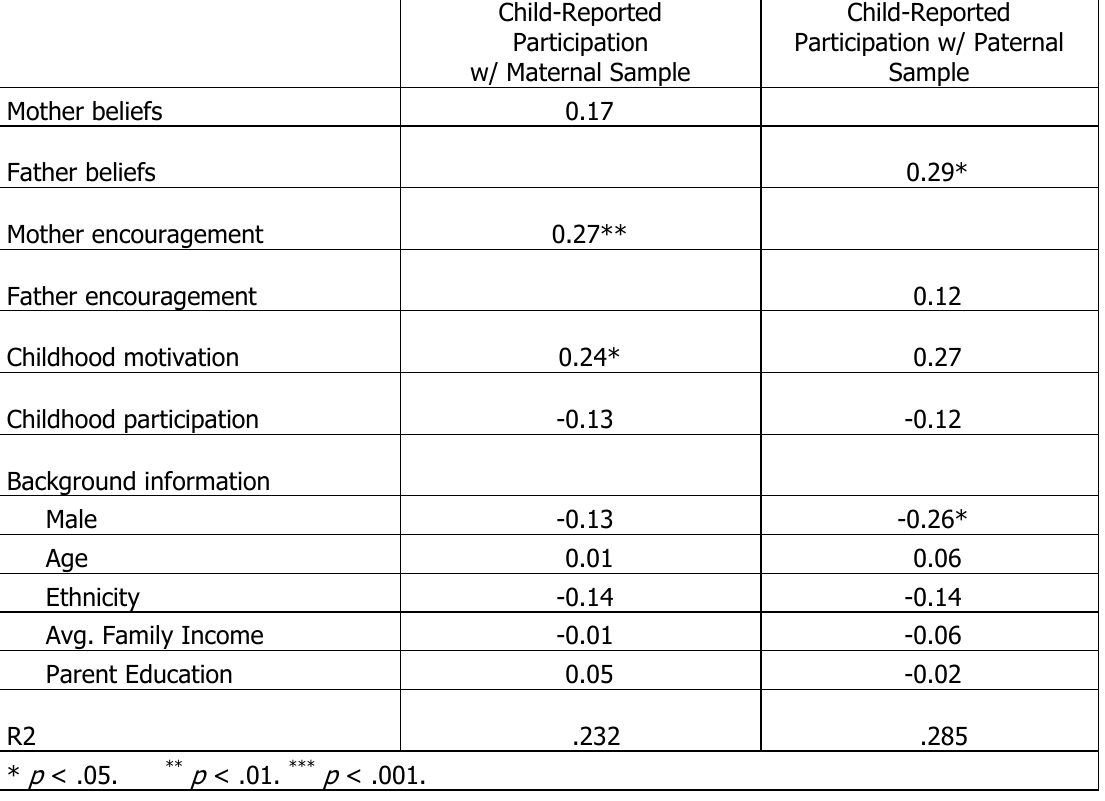
Standardized OSL regression results (N = 160 Mothers, 95 Fathers) for middle childhood (Wave 4) measures predicting average sports participation frequency in adolescence (Wave